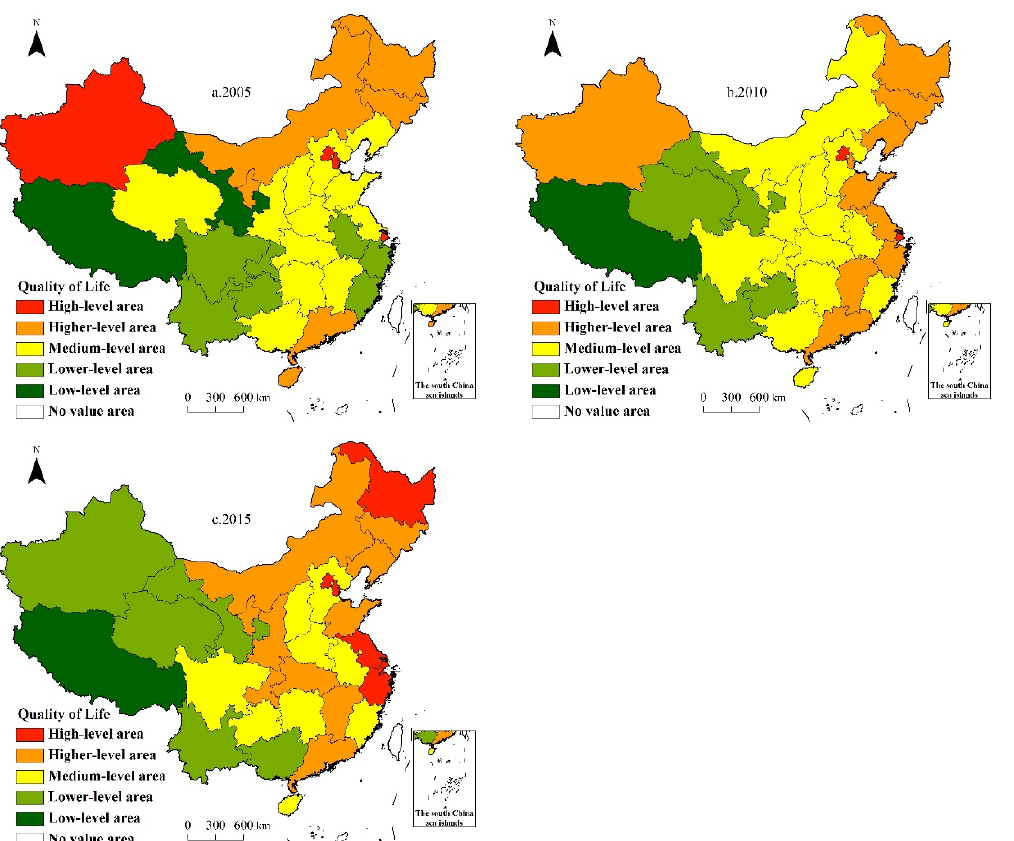
Figure 3. Comprehensive measurement of quality of life for the oldest-old in China, 2005–2015. Note: Standard map drawing based on the standard map service system of the Ministry of Natural Resources (the drawing number is GS (2019)1833). The base map is not modified. Table 4. Results of model